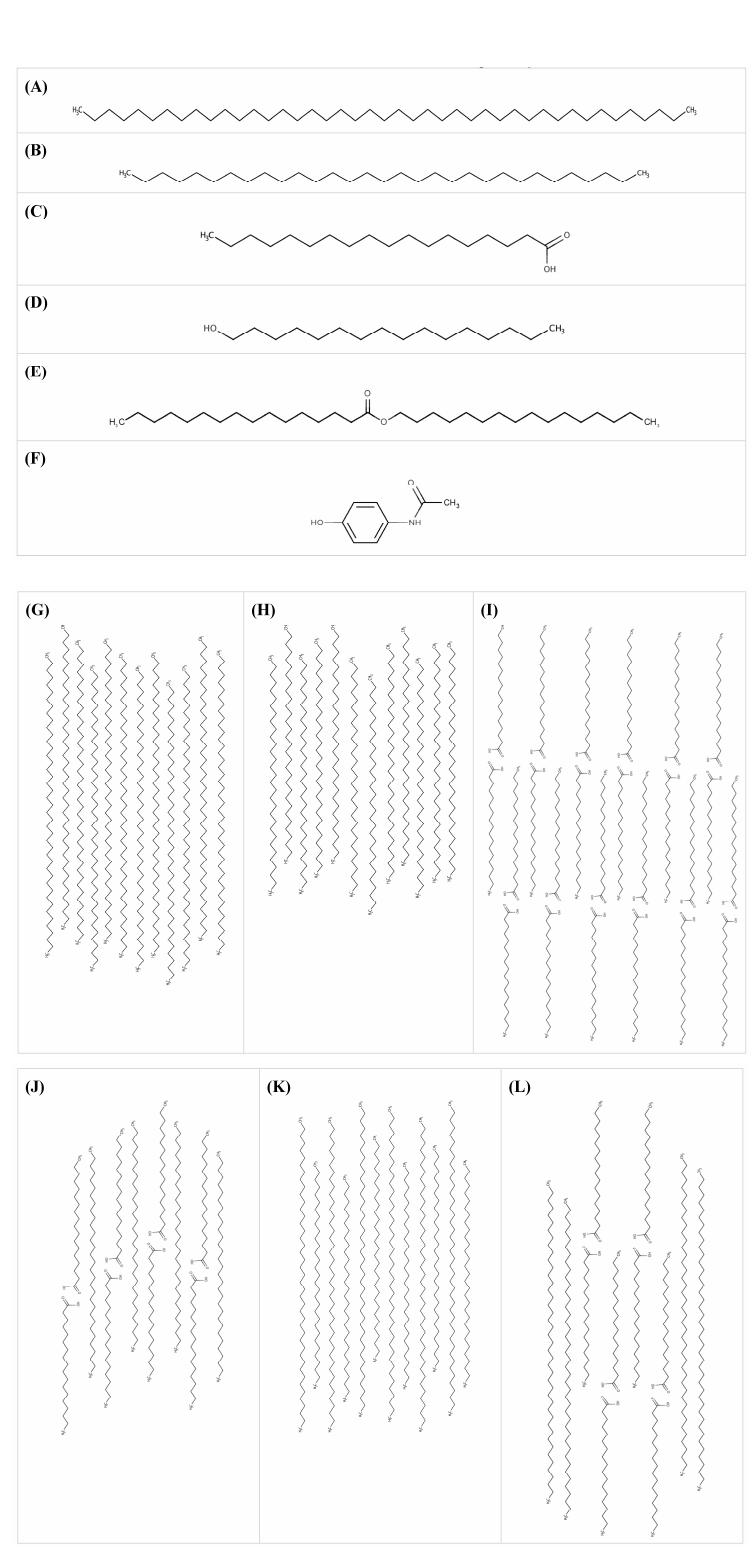
Figure 4. Molecular structures of ( A ) PW84; ( B ) PW59; ( C ) SA; ( D ) CA; ( E ) CE; ( F ) paracetamol; and representative postulated conformations of ( G ) PW84 molecules; ( H ) PW59 molecules; ( I ) SA molecules; ( J ) PW59:SA blend; ( K ) PW84:PW59 blend; and ( L ) PW84:SA blend under shear, drawn using MarvinSketch program (MarvinSketch 17.1.23.0, ChemAxon, Budapest, Hungary), which takes into consideration the energy of the conformation of molecules. Note: Only representative conformations are shown. The rest are presented in Supplementary Materials (Figure